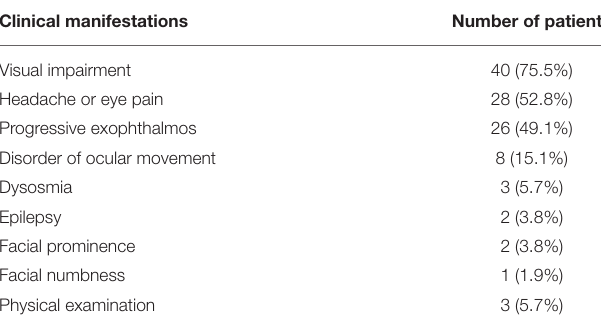
TABLE 2 | Different clinical manifestations of the patients.